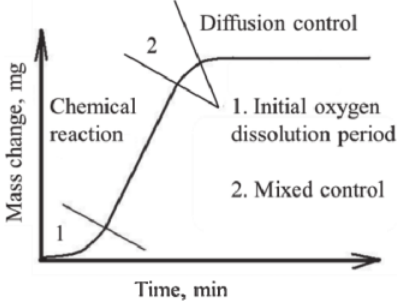
Fig. 4: Illustration of the plausible steps in the oxidation mechanism marked on a typical isothermal mass change curve.